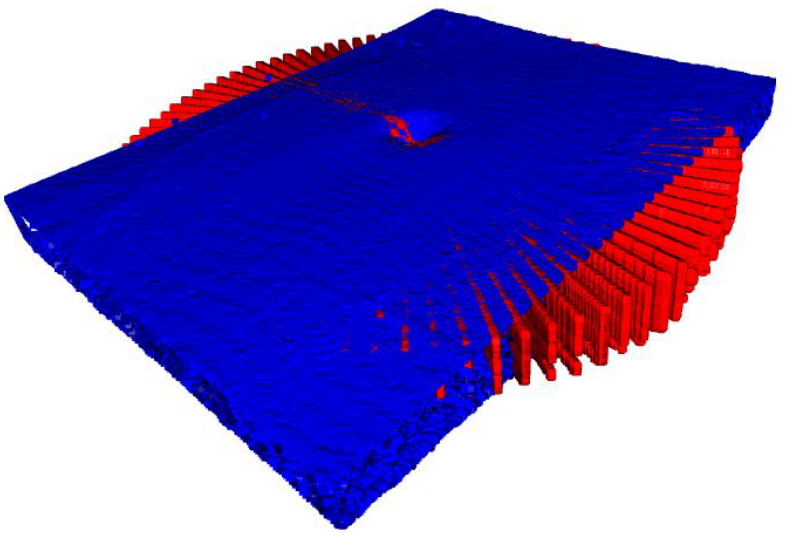
Figure 4. Visualized is a tilted and rotated view of the two point clouds after the ICP algorithm was completed, with the radial reconstructed point cloud as red and the linear reconstructed point cloud as blue